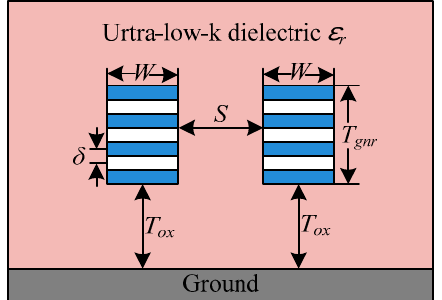
Figure 1. Geometries of two-line coupled multilayer graphene nanoribbon (MLGNR) interconnects using the ultra-low-k dielectric material.